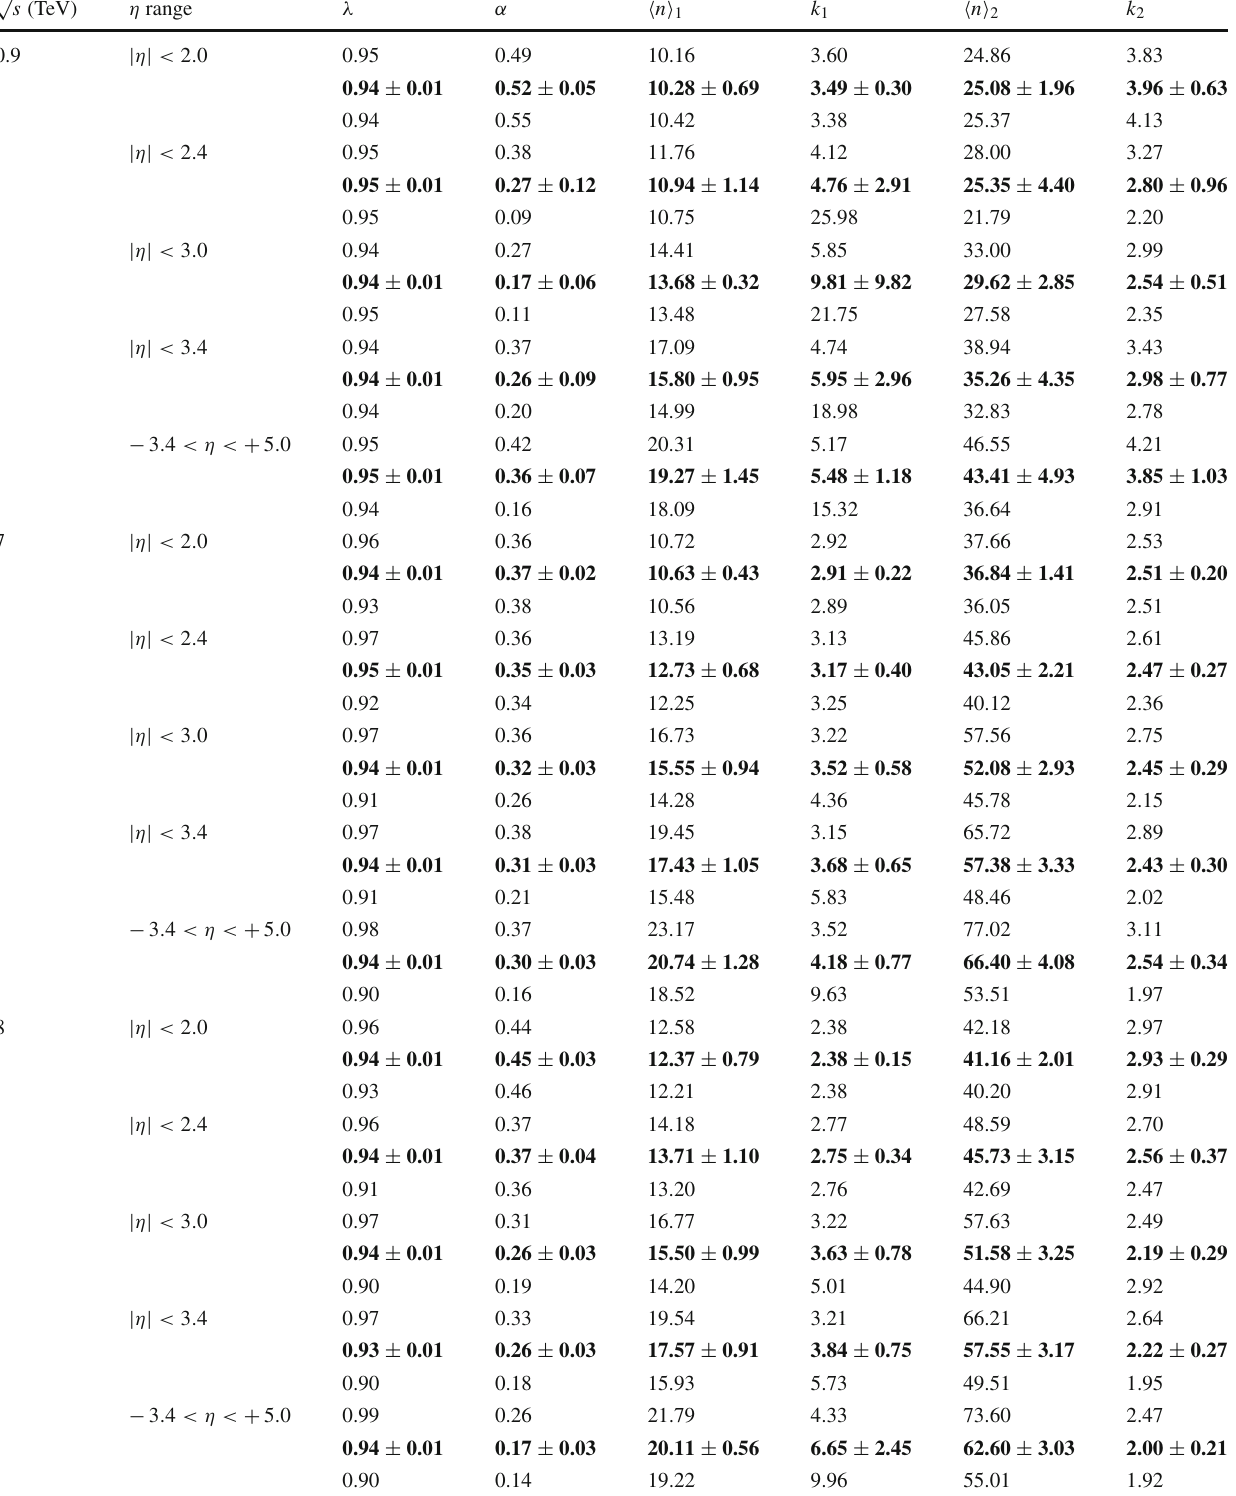
Table 4 Double NBD fit parameters for multiplicity distributions, NSD events. The central values of the parameters are printed in bold with their relative uncertainty, while the top row shows the upper bound fit parameters, and the bottom row the lower bound ones √ s